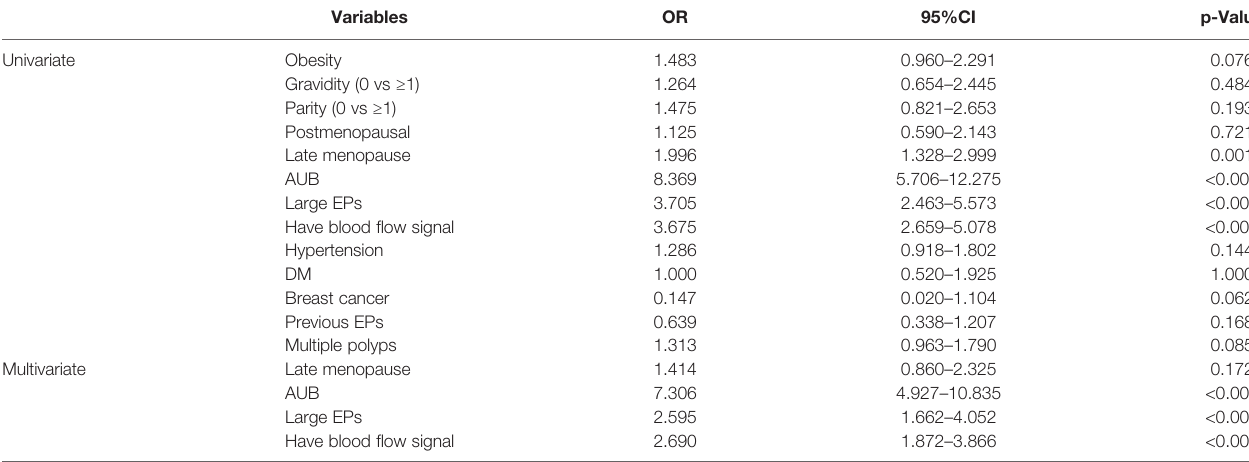
TABLE 3 | Univariate and multivariate analysis of demographic and clinical data between benign and malignancy groups in training set. Variables OR 95%CI p-Value Univariate Obesity